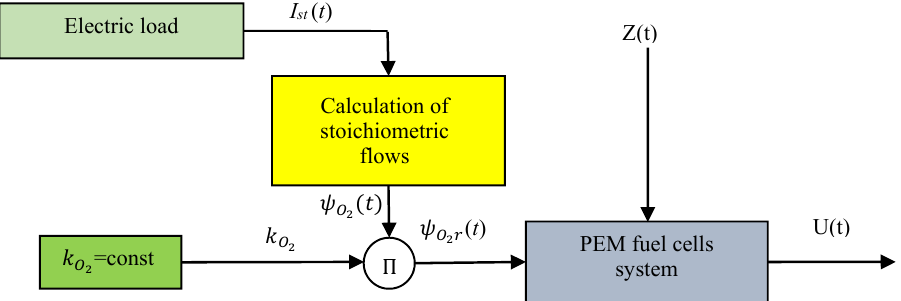
Figure 2. Diagram of oxidant flow control system in typical solutions. I st ( t ), stack current; Z(t), disturbance, U(t), voltage of individual cells in the stack.